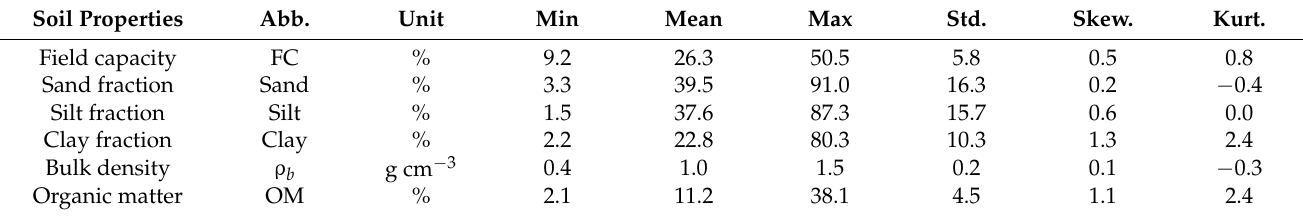
Table 1. Descriptive statistics for forest soil properties used in this study.